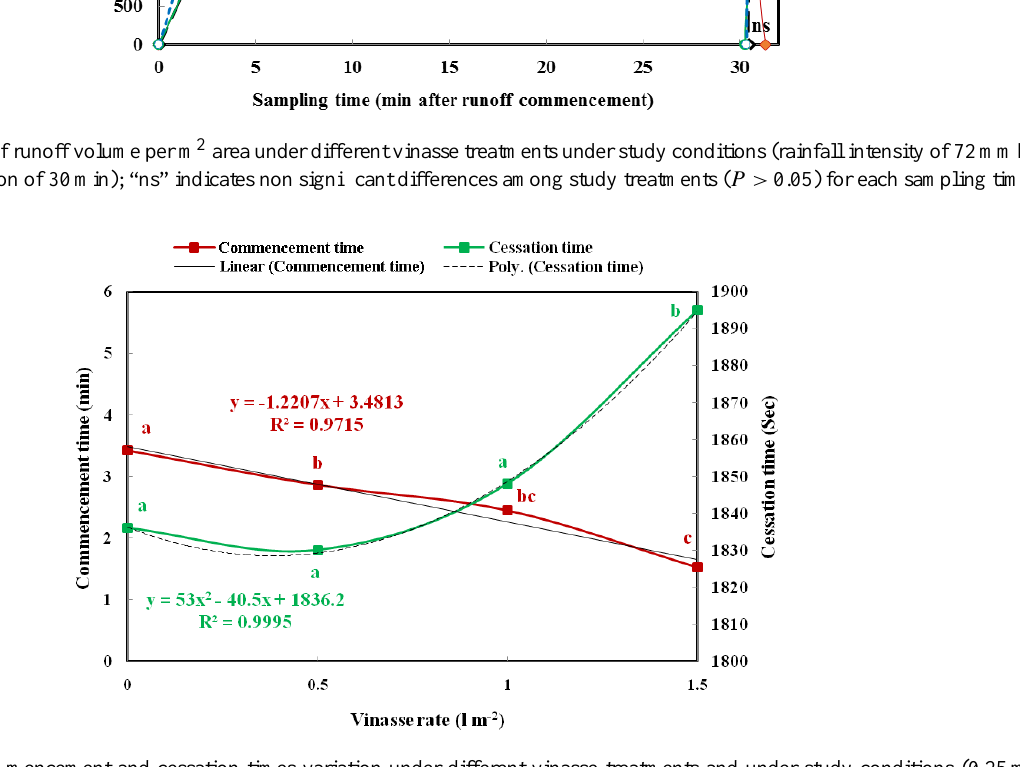
Figure 3. Runoff commencement and cessation times variation under different vinasse treatments and under study conditions (0.25m − 2 small plot, rainfall intensity of 72mmh − 1 and experiment duration of 30min); different letters indicate significant differences among study treatments ( P < 0.05) for each sampling